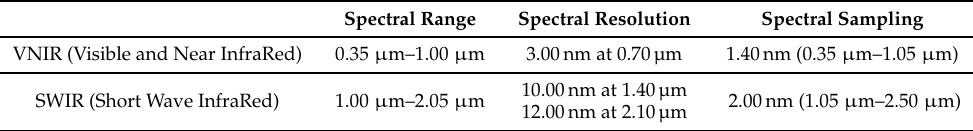
Table 2. Analytical Spectral Device (ASD) FieldSpec Pro